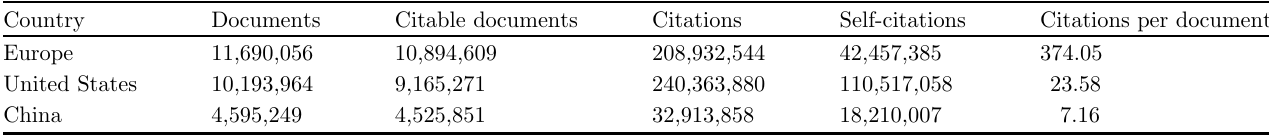
Table 2. The International Scienti fi c Journal & Country Ranking (SJR), United States, China, and the European Union (United Kingdom excluded due to Brexit) [ according to